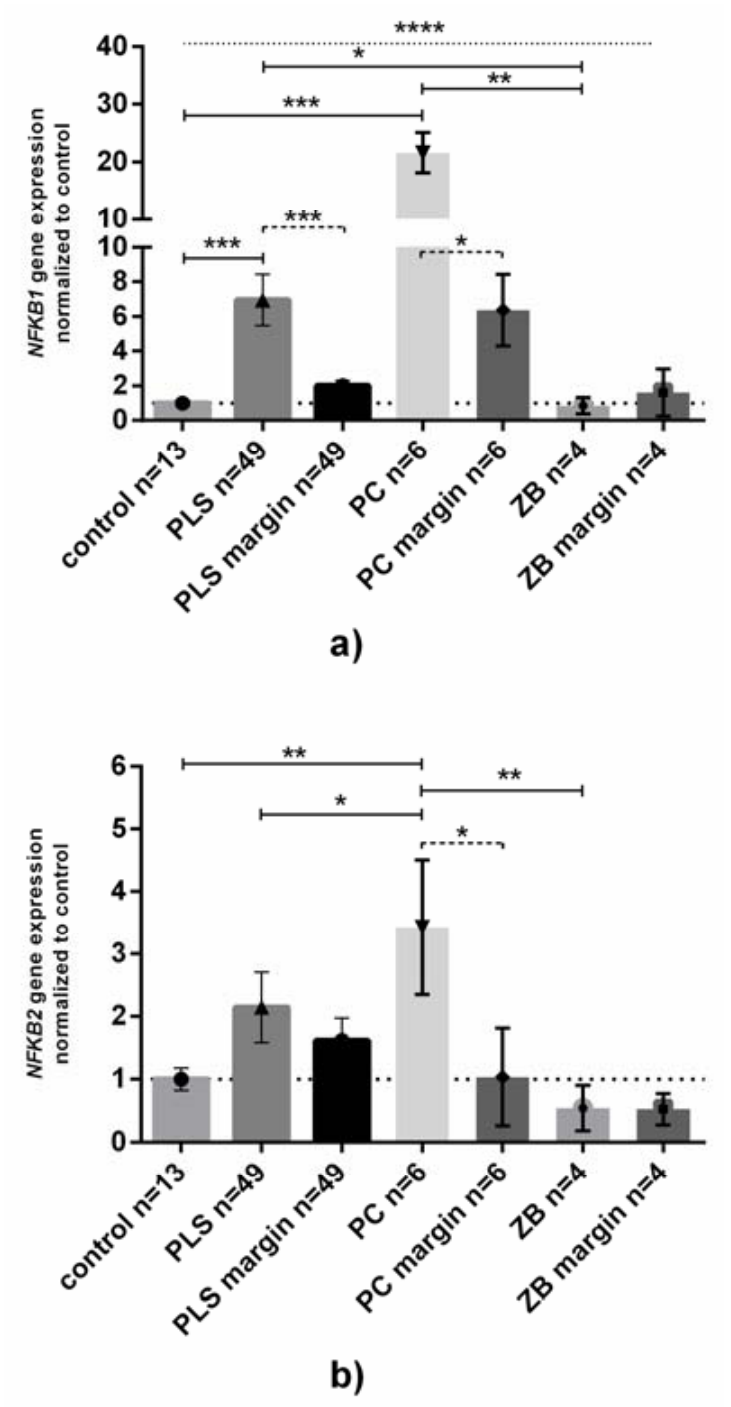
Figure 1. NFKB1 and NFKB2 gene expression at the mRNA level in penile tissue. Gene expression of ( a ) NFKB1 and ( b ) NFKB2 was assessed as described in Methods. Bars and whiskers represent the mean ± SD normalized to control foreskin samples (presented as 1). * p < 0.05, ** p < 0.01, *** p < 0.001, **** p < 0.0001 (Wilcoxon signed-rank test between inflamed-unchanged samples, dashed line; Mann–Whitney U test between each group, solid line; Kruskal–Wallis ANOVA test between all groups, dotted line). Abbreviations: PLS, penile lichen sclerosus; PC, penile cancer; ZB, zoon balanitis; margin, histologically confirmed healthy fragment of surgically removed foreskin.